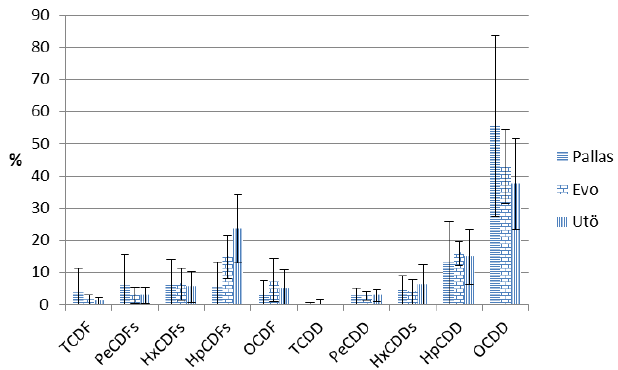
Figure 5. PCDD/Fs (toxic congener) homolog groups pg/L calculated as % of the sum of all homologs.